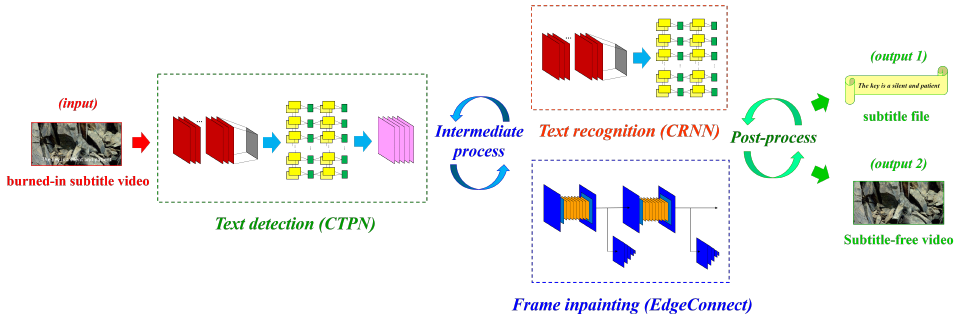
Figure 1. Model diagram of the entire deep-learning-based system for burned-in subtitle video reconstruction, which consists of three joint deep neural networks: CTPN (for text detection), CRNN (for text recognition), and EdgeConnect (for video